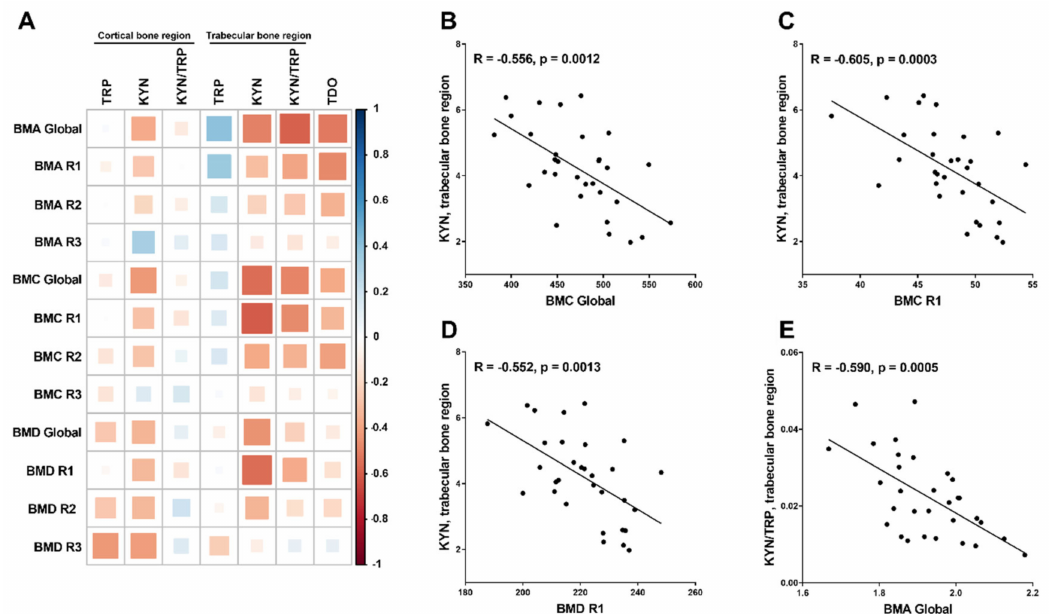
Figure 4. The association between components of the kynurenic system in bone homogenates and the parameters of bone mineral status in rats with CKD treated with LP533401 ( A ) and a detailed graphic presentation of the strongest among them ( B – E ). The size and the color intensification demonstrate the strength of the correlation (larger and darker circles represent a strong correlation). Blue colors—positive correlations; red colors—negative correlations. BMA—bone mineral area, BMC—bone mineral content, BMD—bone mineral density. R1—the distal metaphysis subregion, composed mostly of the trabecular tissue bone. R2—midshaft area subregion, constituted mostly of cortical bone tissue. R3—femoral neck subregion, built of a similar proportion of trabecular and cortical bone